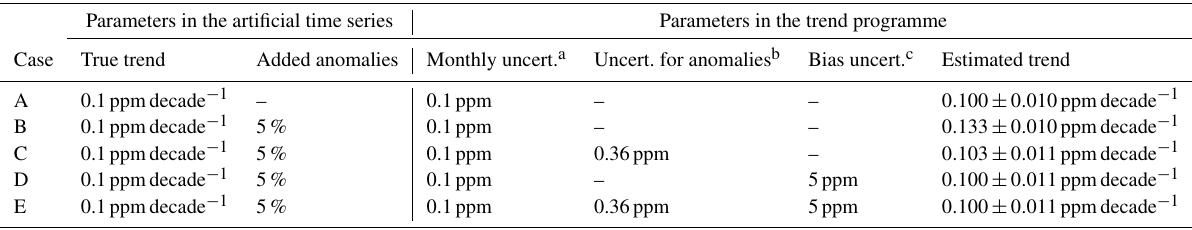
Table 2. Summary of the artificial ozone time series and the different model parameters used to correct the trend estimation for artificially added anomalies.